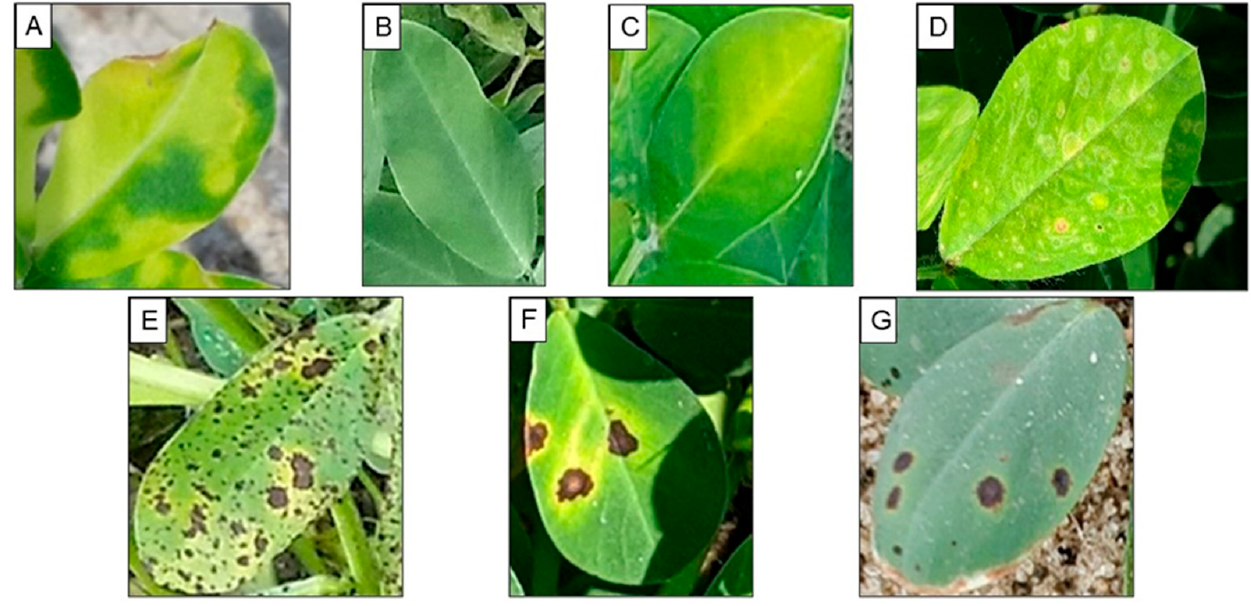
Figure 2. Symptoms used to build peanut diagnostic models and their causal agents: ( A ). Paraquat injury, abiotic, ( B ). Healthy, ( C ). Hopperburn, Empoasca fabae , ( D ). Tomato spotted wilt, Tomato spot- ted wilt virus , ( E ). Late leaf spot, Nothopassalora personata , ( F ). Provost injury, abiotic, and ( G ). Surfac- tant injury, abiotic.